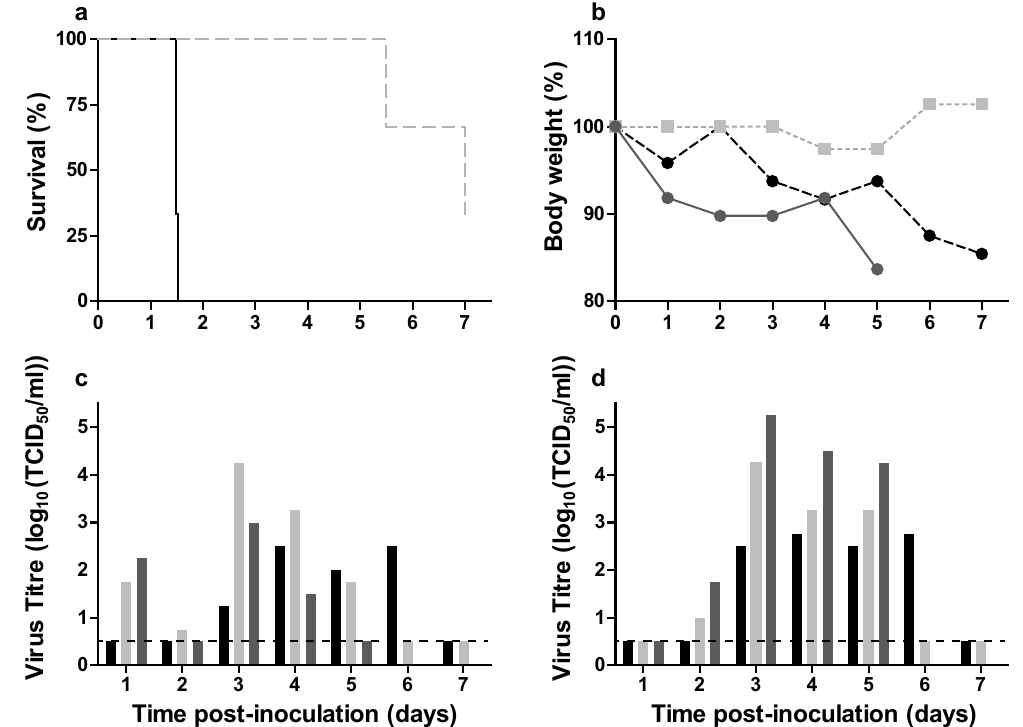
Figure 1. Survival, body weight and viral shedding of chickens upon inoculation with INDO AT6 . ( a ) Survival (%) of chickens inoculated with INDO WT (black line) or INDO AT6 (light grey dotted line). ( b ) Body weight (%) of chickens inoculated with INDO AT6 . ( c ) Individual viral titres in oropharyngeal swabs collected from chickens inoculated with INDO AT6 . ( c ) Individual viral titres in cloacal swabs collected from chickens inoculated with INDO AT6 . In panels b, c and d, similar colour coding is used to identify individual animals. The lower limit of detection is indicated by the dashed lines.